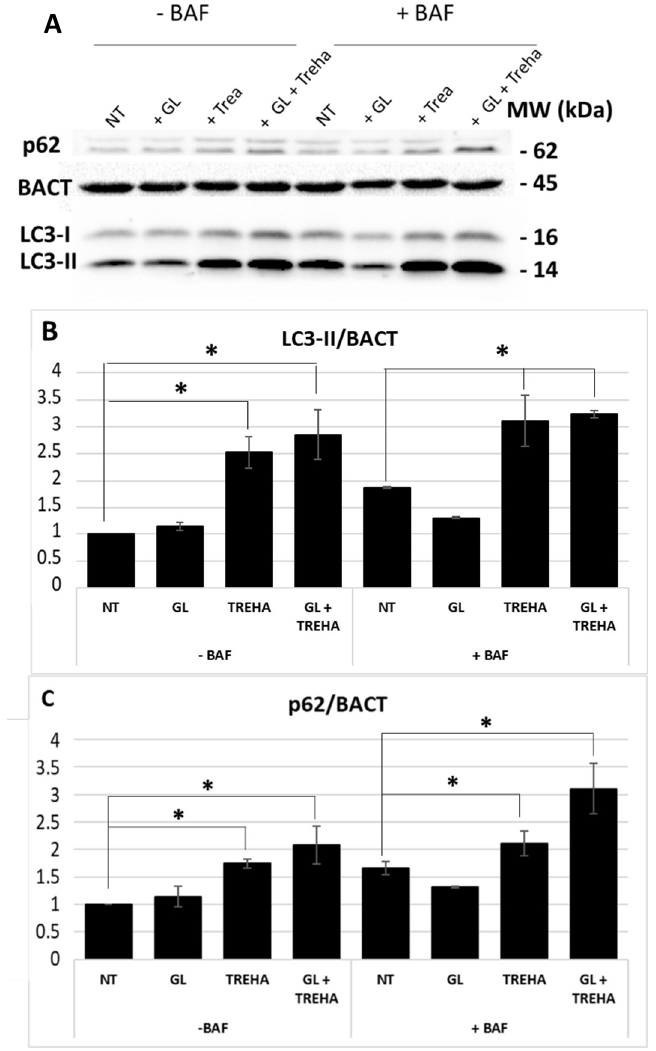
Figure 10. LC3-II and p62 proteins expression at 24 h p.t. after PT-gliadin (1 µg/µL) and trehalose (100 mM) administration. The LC3-II and p62 expressions were analyzed through immunoblotting ( A ) and densitometric analyses ( B , C ) and normalized to BACT levels [23]. Normalized values are reported on the y-axis as arbitrary units. Molecular weights (kDa) and SE bars are reported. The asterisks indicate p < 0.05, Anova one-way, as compared with NT samples. The experiments were performed in triplicate.